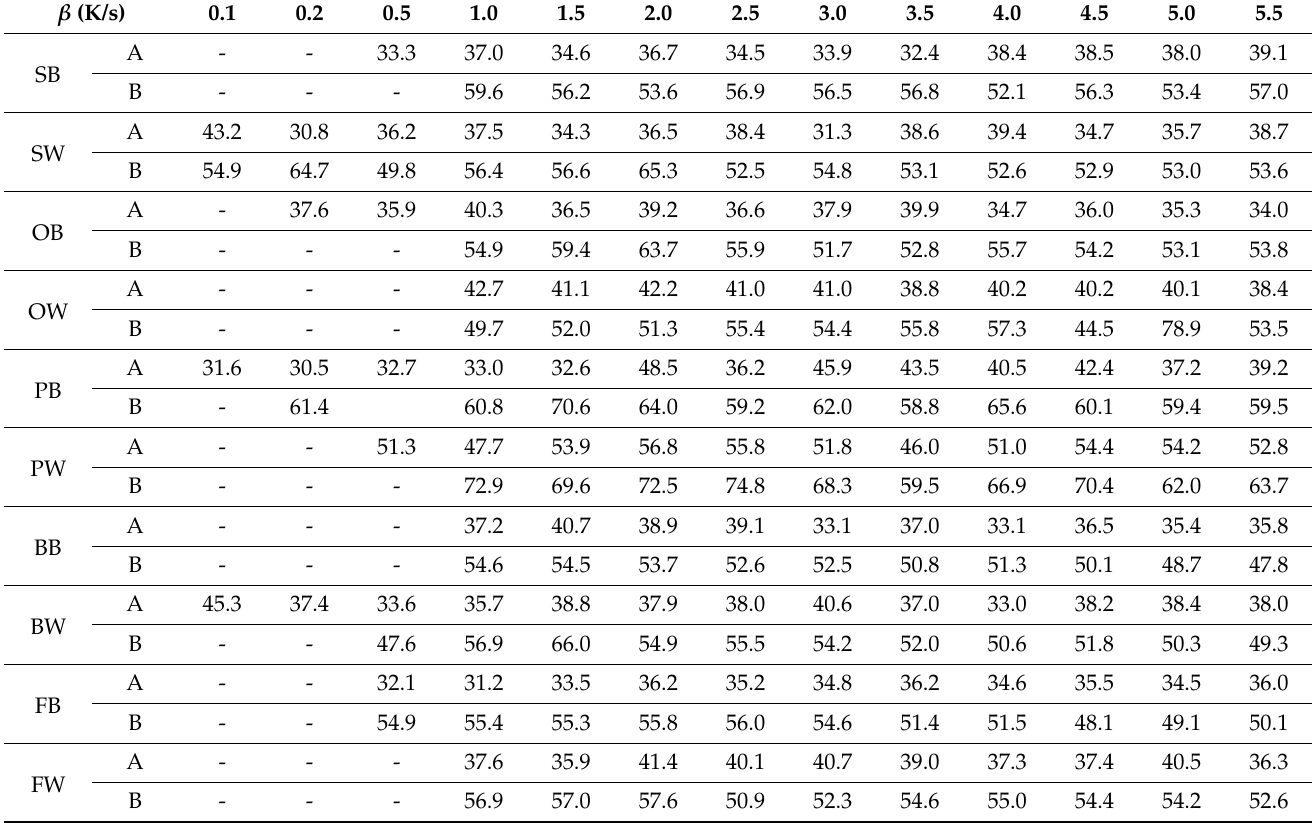
Table 5. Ignition capacity calculation for ten wood samples with Method A and Method B by 5% heat release